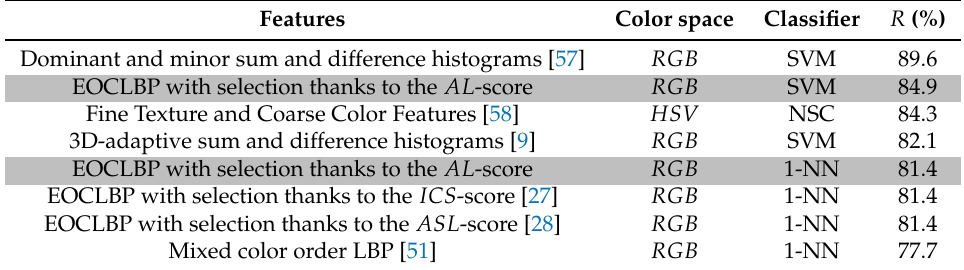
Table 8. Comparison between the classification accuracies reached with the NewBarktex